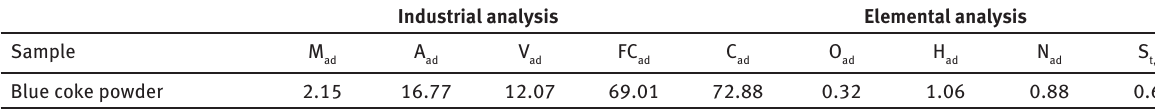
Table 1: Industrial analysis and elemental analysis of the blue coke powder.